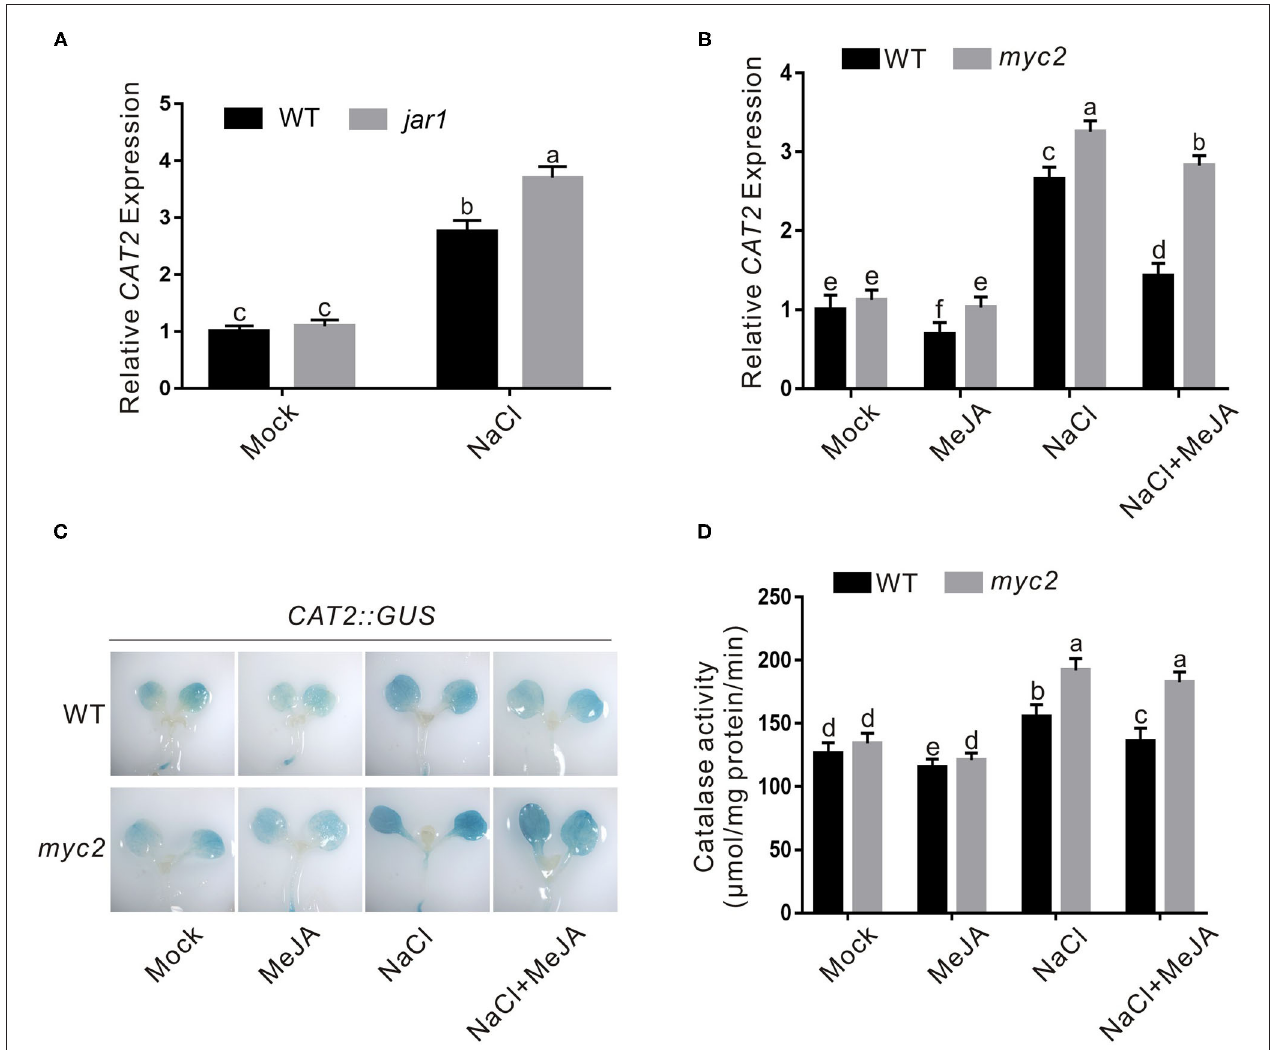
FIGURE 4 | JA represses salt-induced CAT2 expression. (A) The expression of CAT2 in the wild-type and jar1 mutant seedlings treated with NaCl. The 5-day-old wild-type and jar1 mutant seedlings treated with or without 125mM NaCl for 1 day were used to assay CAT2 expression by qRT-PCR. ACTIN2/8 was used as the reference gene. (B) The expression of CAT2 in the wild-type and myc2 mutant seedlings treated with MeJA and/or NaCl. The 5-day-old wild-type and myc2 mutant seedlings treated with or without 2.5 µ M MeJA and/or 125mM NaCl for 1 day were used to assay CAT2 expression by qPCR. ACTIN2/8 was used as the